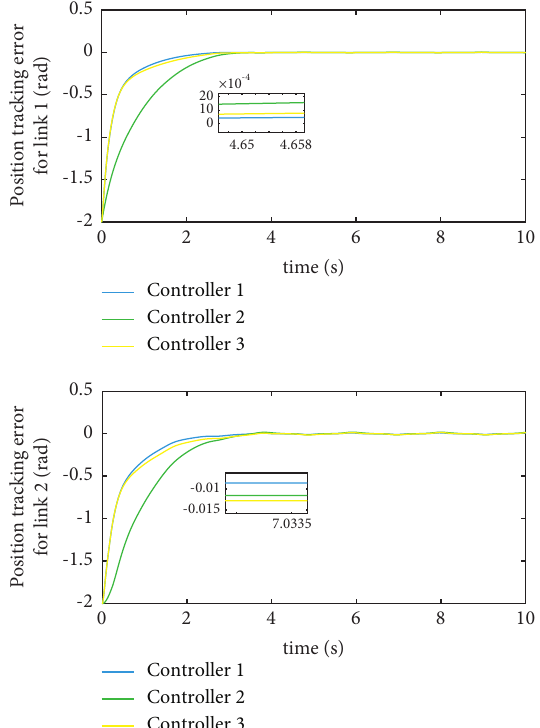
Figure 2: Comparison of tracking error of